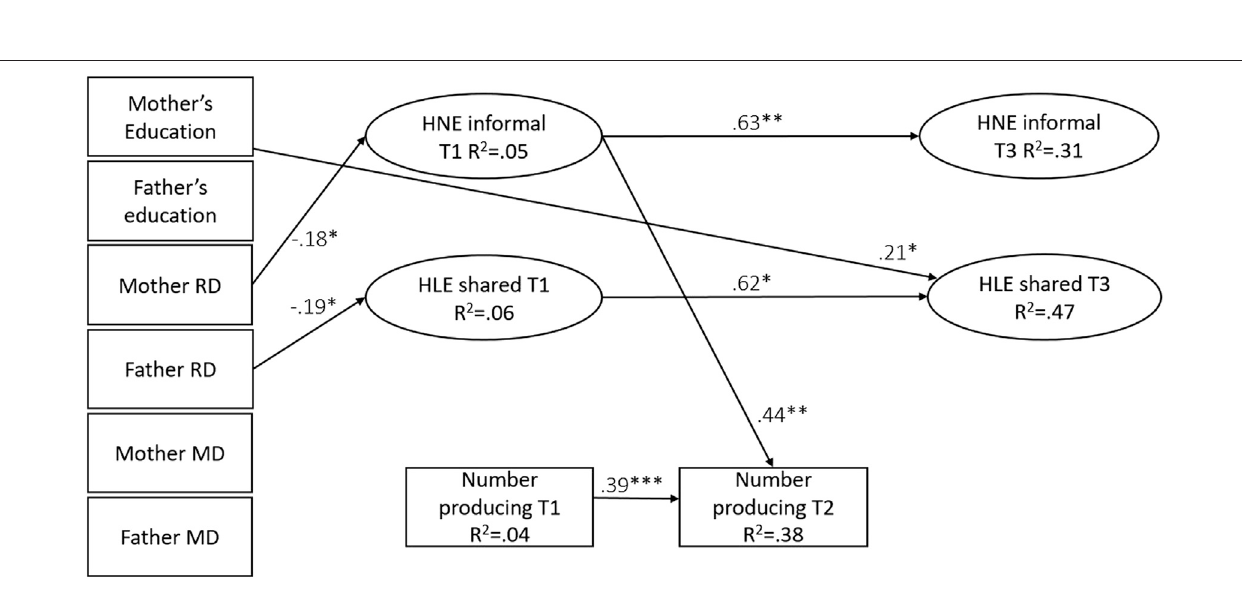
Frontiers in Education |